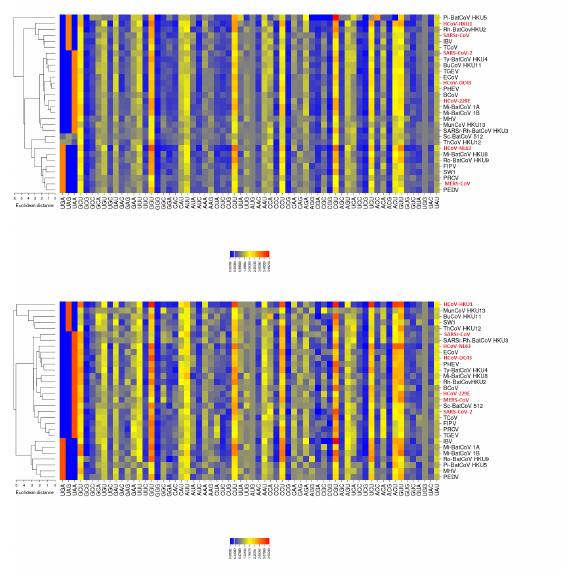
Figure A5. Heatmaps of RSCU vectors for genes RdRP ( upper panel ) and S ( bottom panel